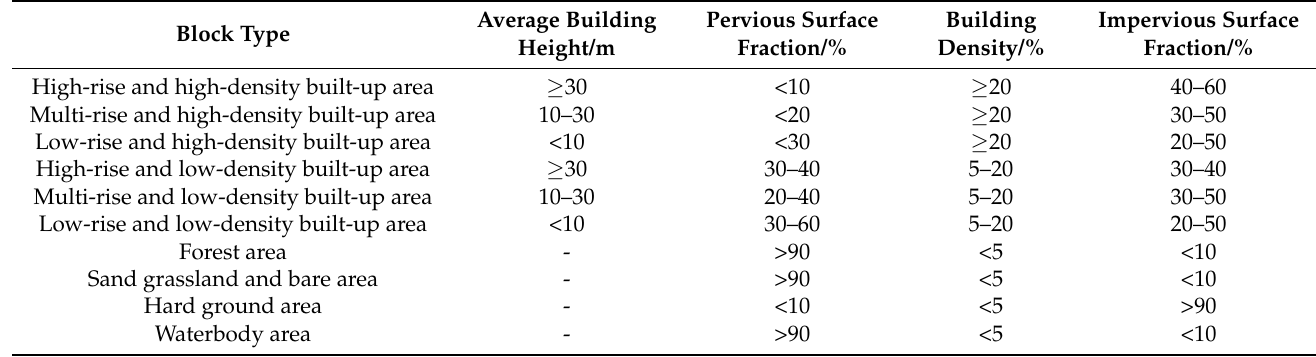
Table 2. Range of different block division